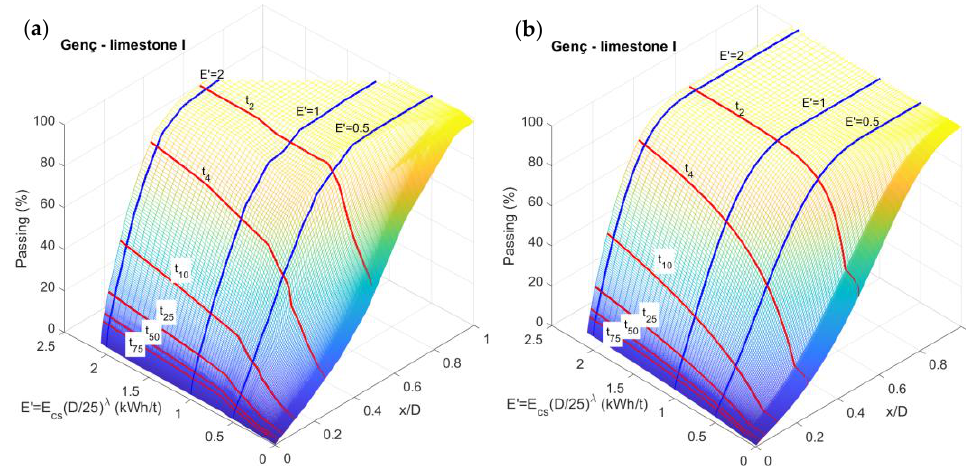
Figure 15. 3D breakage plots for Genç’s et al. [24] limestone I. ( a ) from data. ( b ) from double fan model (direct fit, constant 𝜆 , 𝐸 𝑚𝑖𝑛 ≥ 0 ).